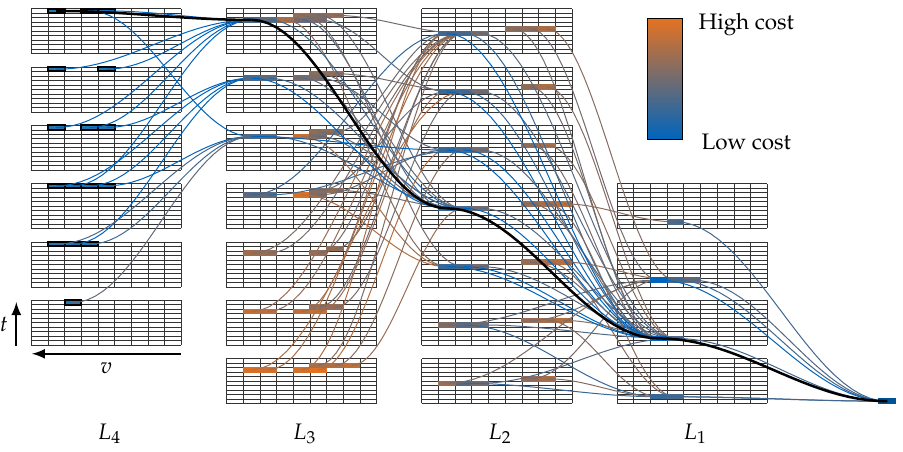
Figure 7. Generated graph for planning step d (cid:13) . Only the relevant spatial nodes and edges that contribute to an optimal path to reach a spatiotemporal node are shown for a clearer picture. The reached nodes are qualitatively colored according to their cost-to-come and the edges according to their cost. The optimal path is shown in black, and all nodes satisfying the goal condition are outlined in